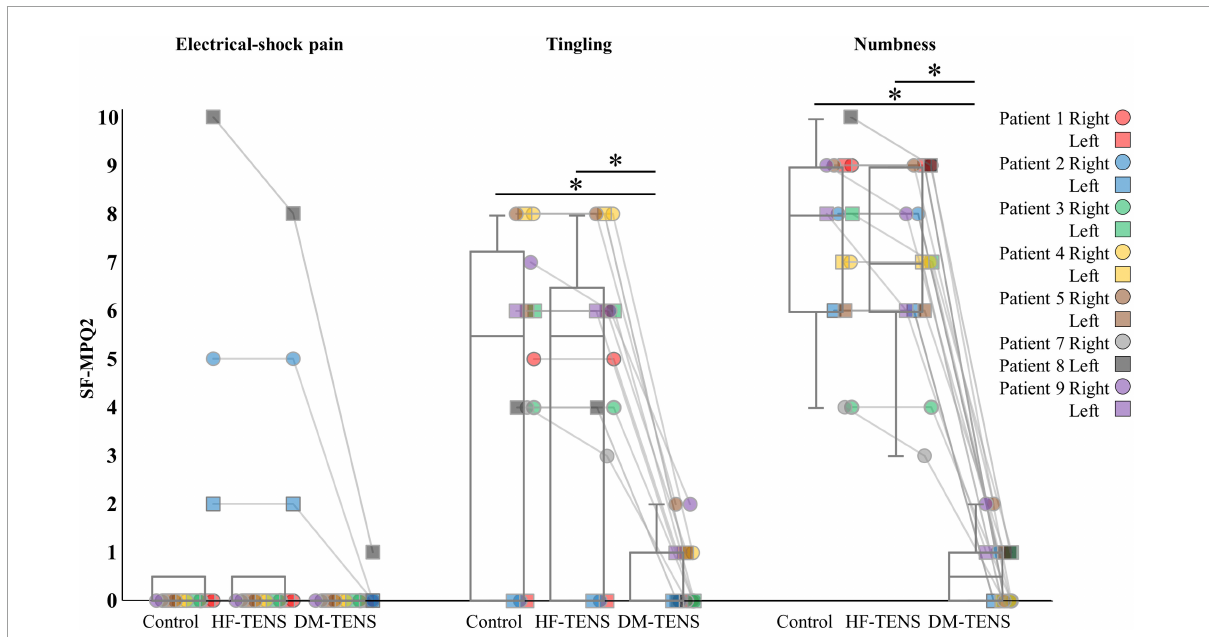
FIGURE4 The specific items of the SF-MPQ-2 for each patient. HF-TENS: high-frequency TENS, DM-TENS: dysesthesia-matched TENS. * p < 0.05.